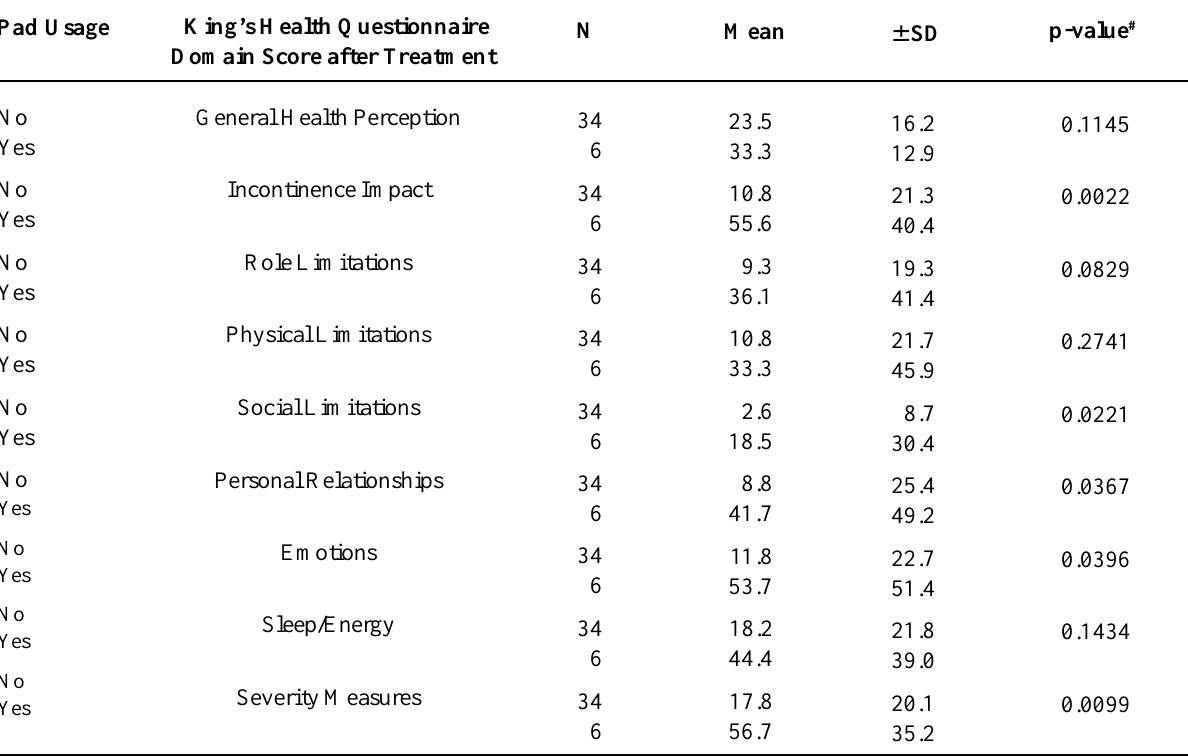
Table 5 – Study of the external responsiveness of King’s Health Questionnaire, comparing post-treatment questionnaire scores and pad